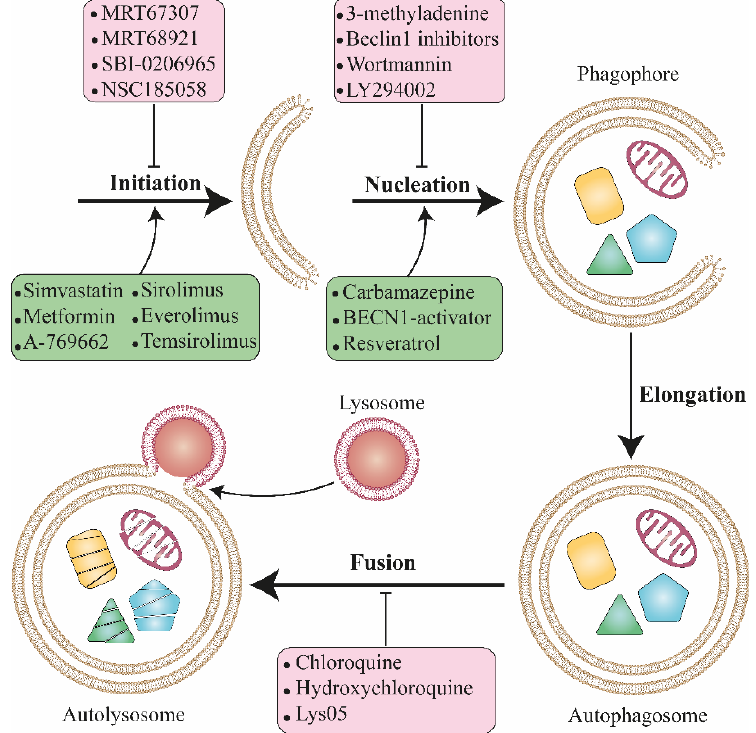
Figure 2. Schematic presentation related to the effect of different drugs on the various stages of autophagosome formation. There are some hot points in autophagosome formation including initiation, nucleation, elongation and fusion. However, various biomolecules and drugs influence these stages and may modulate autophagy to enhance cell survival or mortality in healthy and injured cells.